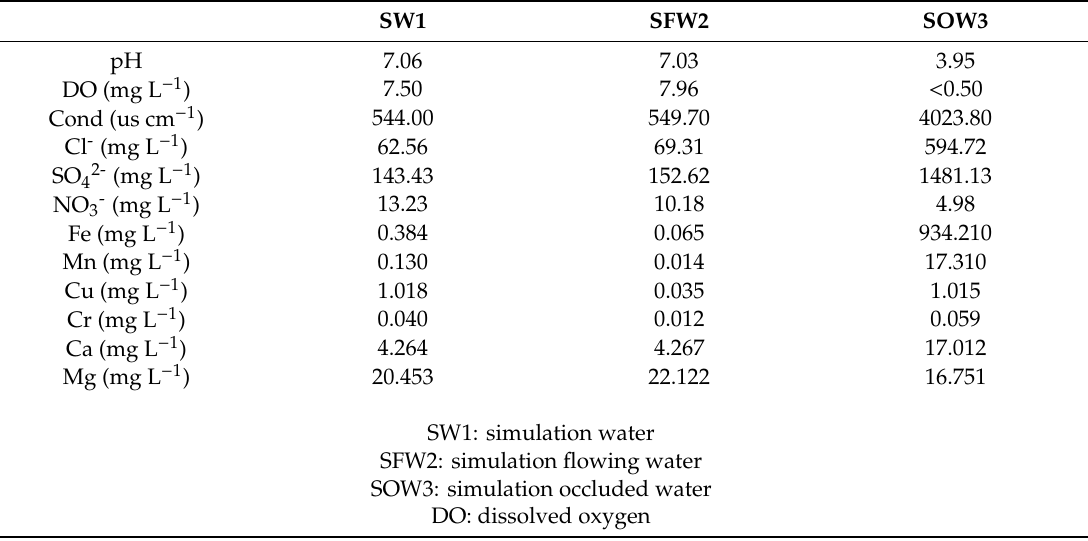
Table 2. The main water quality parameters of SW1, SFW2, and